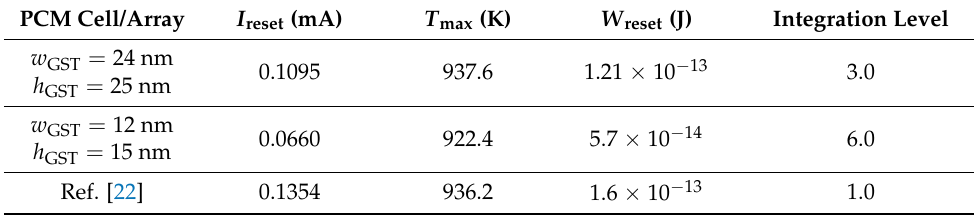
Table 3. Comparison between proposed PCM cells and the cell discussed in